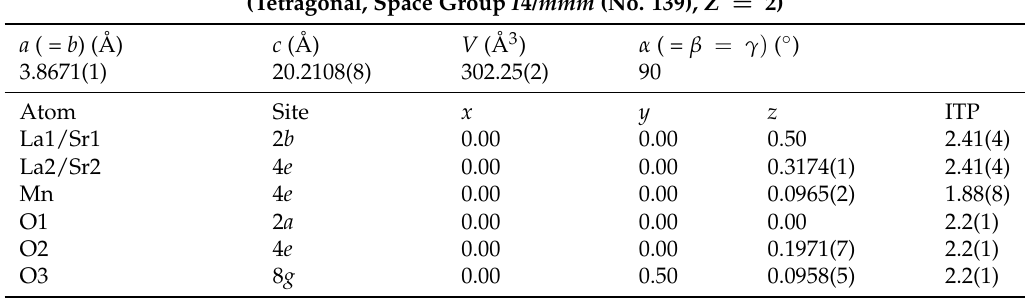
Table 1. Refined room-temperature structural parameters, including lattice constants, unit-cell volume ( V ), atomic positions, isotropic thermal parameters (ITPs), and goodness of refinement, from an in-house XRPD study with a pulverized La 1.37 Sr 1.63 Mn 2 O 7 single crystal. The Wyckoff sites of all atoms were listed. We kept the atomic occupation factors during FULLPROF refinements. We constrained the ITPs of La and Sr ions to being the same, as well as for the O1, O2, and O3 ions. The numbers in parentheses are the estimated standard deviations of the last significant